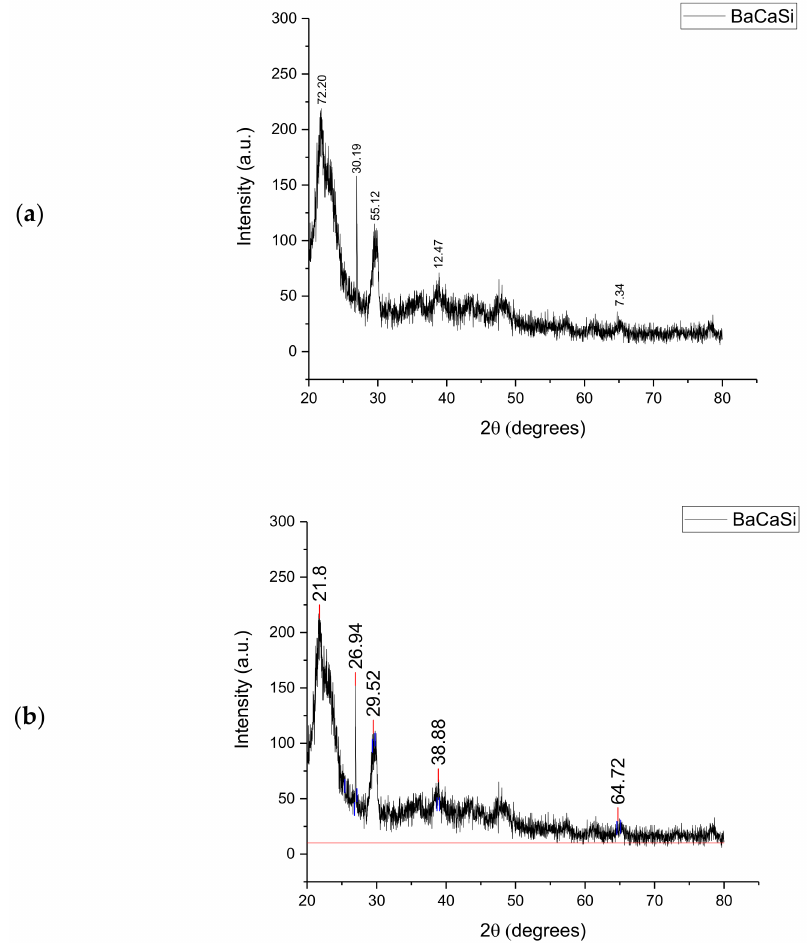
Figure 1. XRD analysis of the Subcoal™ powder: ( a ) peak height, and ( b ) peak area. The red line has been added to calculate the area under the